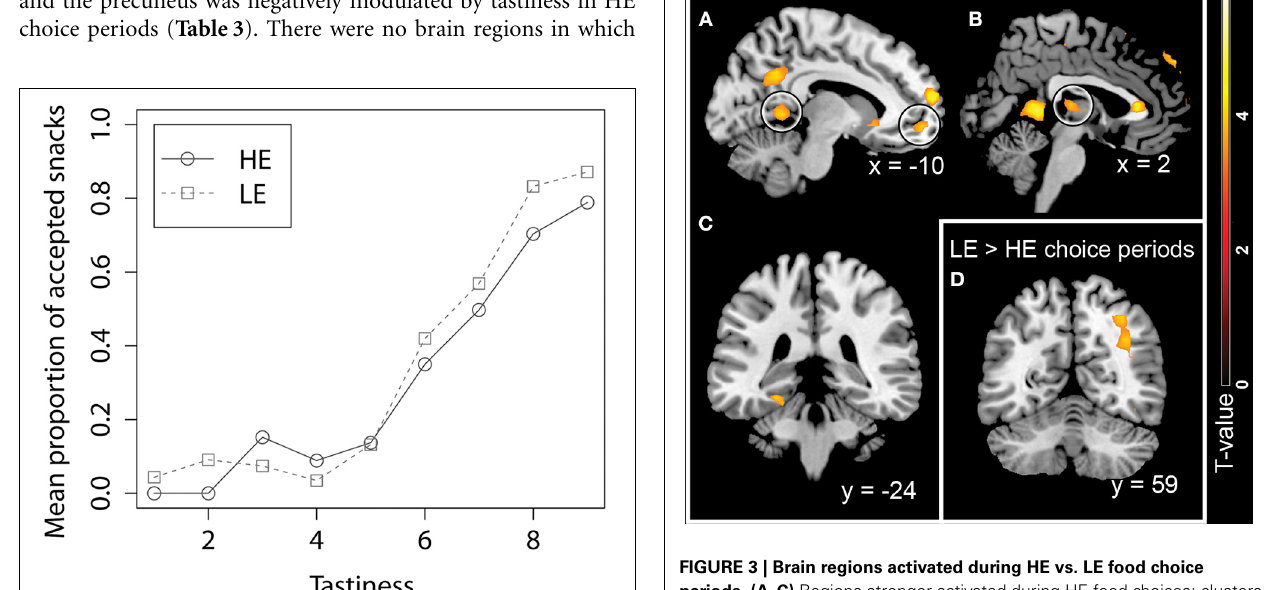
FIGURE 3 | Brain regions activated during HE vs. LE food choice periods. (A–C) Regions stronger activated during HE food choices: clusters in (A) calcarine sulcus and orbital part of superior frontal gyrus, (B) caudate and (C) parahippocampal gyrus. (D) Brain region stronger activated during LE food choice periods: cluster in superior parietal gyrus.